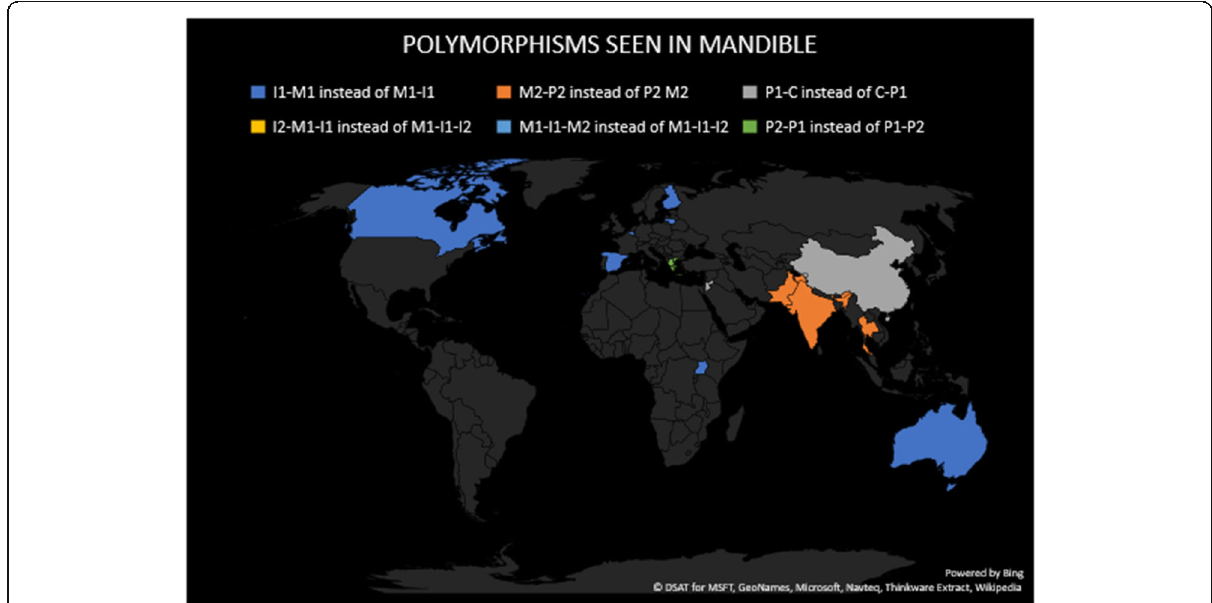
Fig. 3 Polymorphisms seen in the sequence of emergence of mandibular